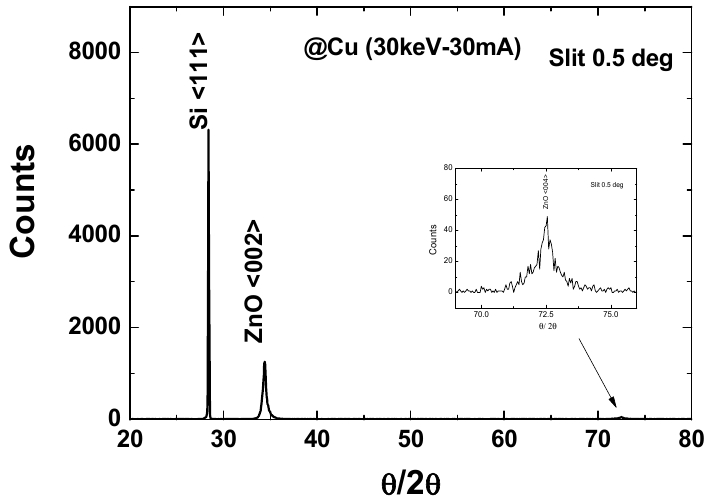
Figure 8. X-ray diffraction of the ZnO film fabricated at modified sputtering conditions on polished surface of <111>-Si plate.